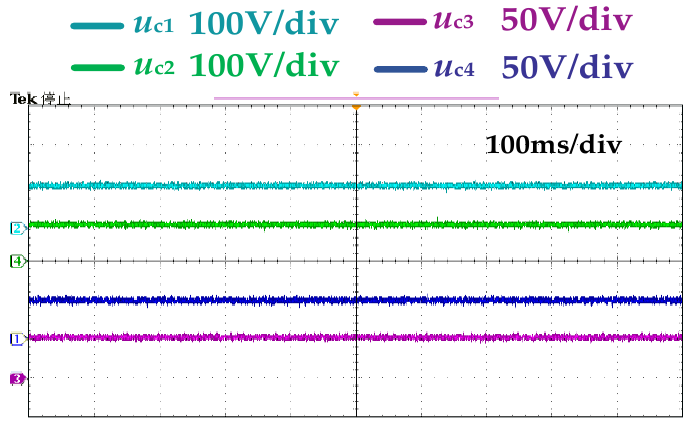
Figure 16. Experimental results of voltages u c1 , u c2 , u c3 and u c4 . Table 4. Comparison with the previous work.